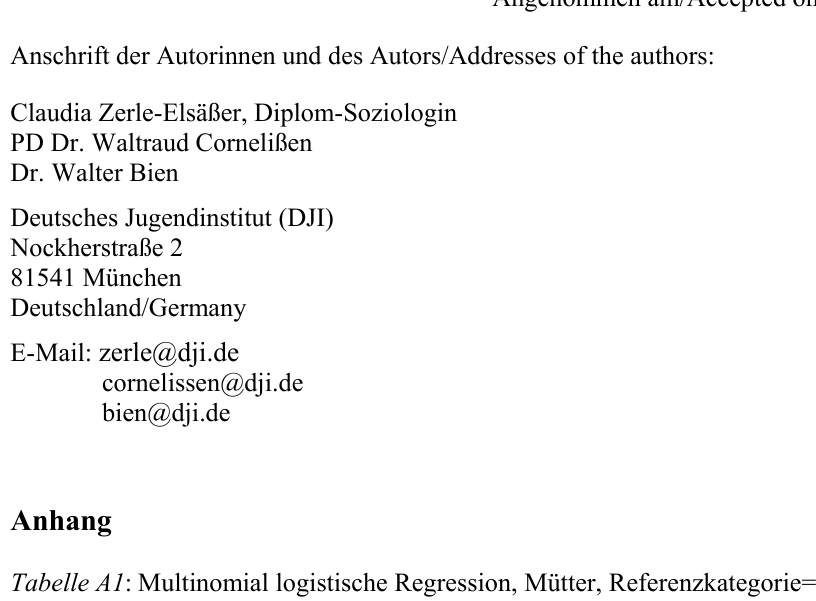
Tabelle A1 : Multinomial logistische Regression, Mütter, Referenzkategorie=späte Mütter Prädiktoren Odds Ratios Höchster Schulabschluss Hauptschulabschluss (1) Mittlere Reife/ Realschulabschluss (2) Fachhochschulreife